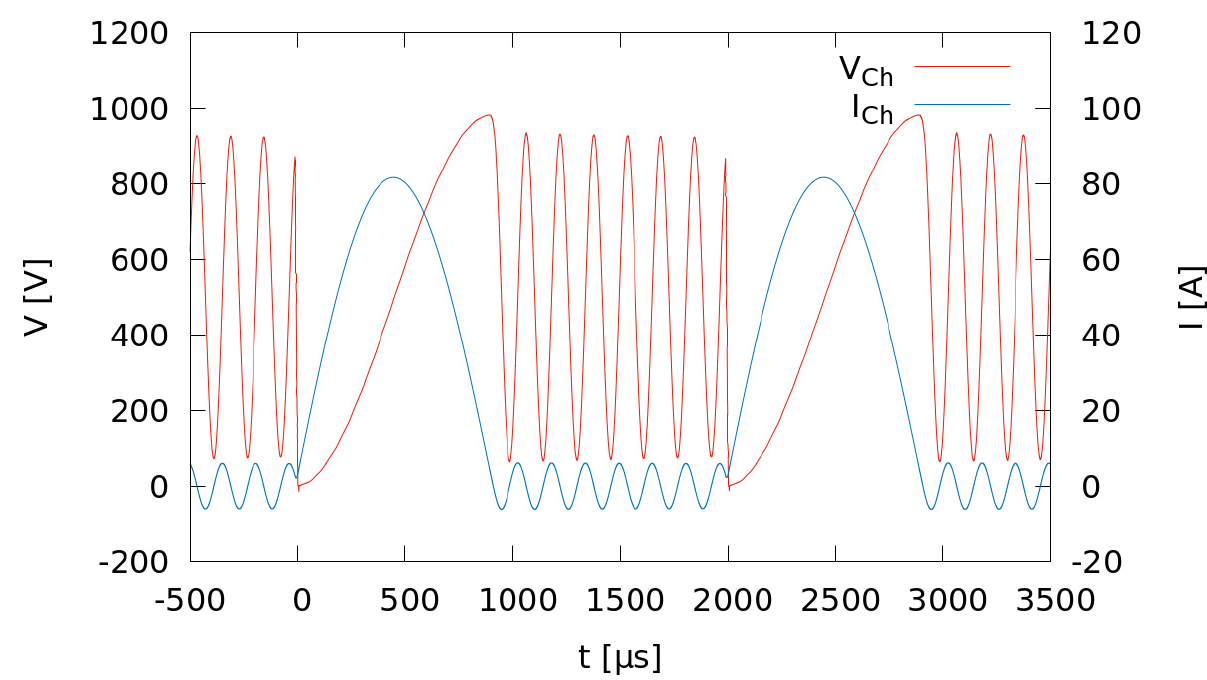
Figure 13. Charging voltage V ch and the charging current I ch at the charging input terminal of the generator, on-time of the solid-state switches: t on = 22 µs.